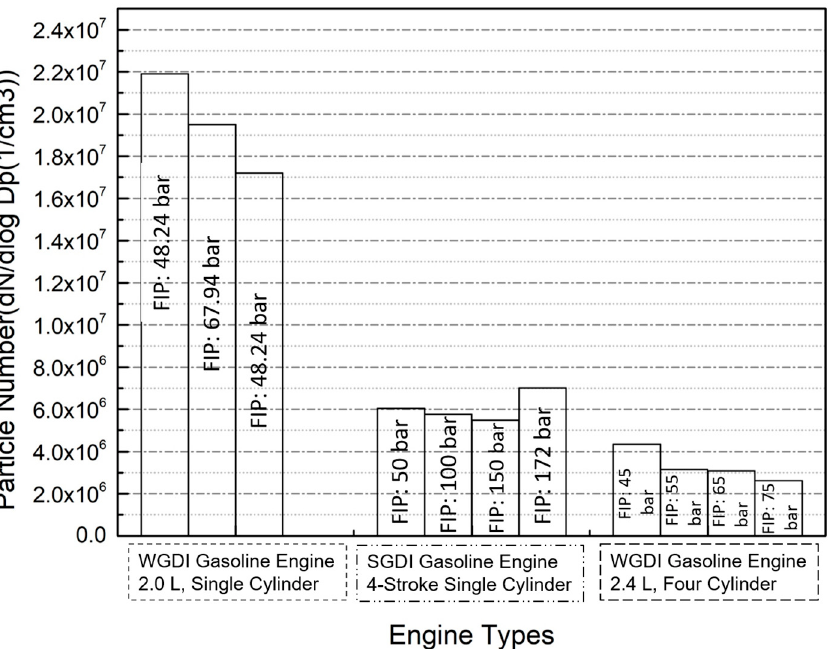
Figure 7. The impact of fuel injection pressure (FIP) variation on particulate number emissions. (presented data from left to right are taken from [2,73], respectively).